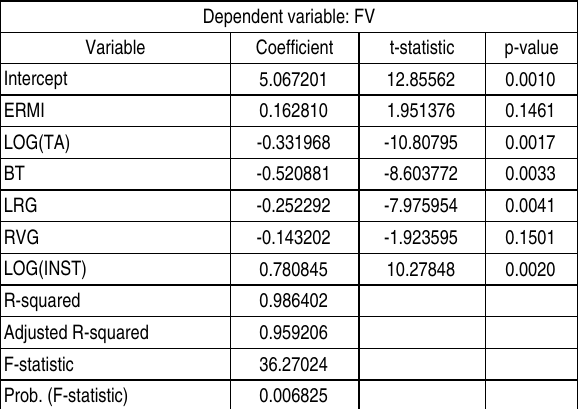
Table 6 . Summary of results of Ordinary Least Square Regression - regression model